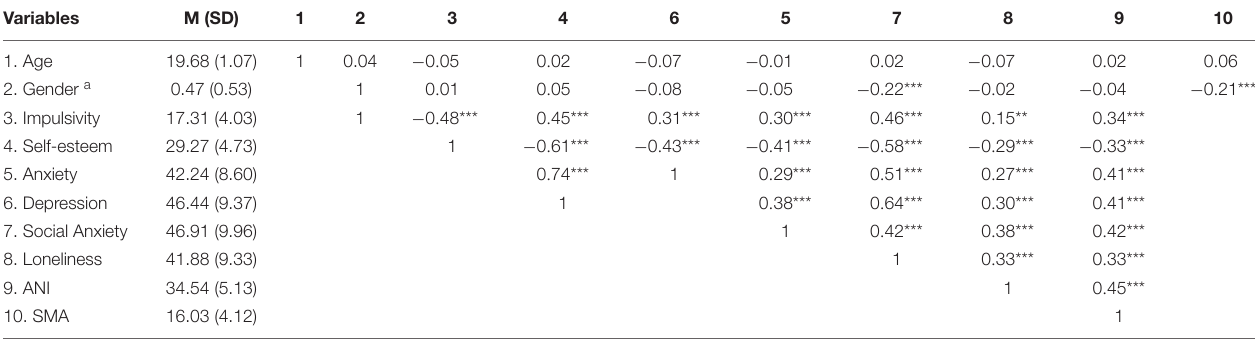
TABLE 1 | Descriptive data and inter-correlations between